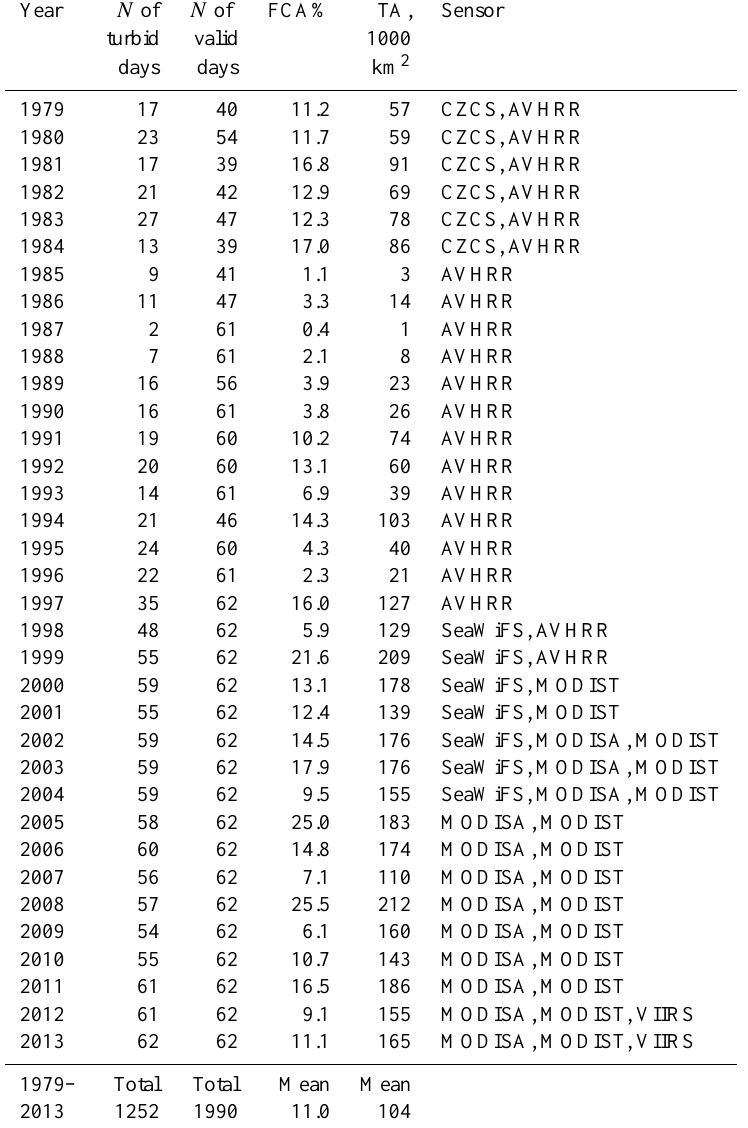
Table 2. Number and type of daily detected (“turbid”) and useable (“valid”) satellite data sets, mean fraction of cyanobacteria accumulations (FCA%), total area covered by accumulations (TA) over the Baltic Sea during the July–August period, and the sensors used in the analysis. For each sensor the number of daily scenes is given in brackets or the combined number of scenes for ocean color